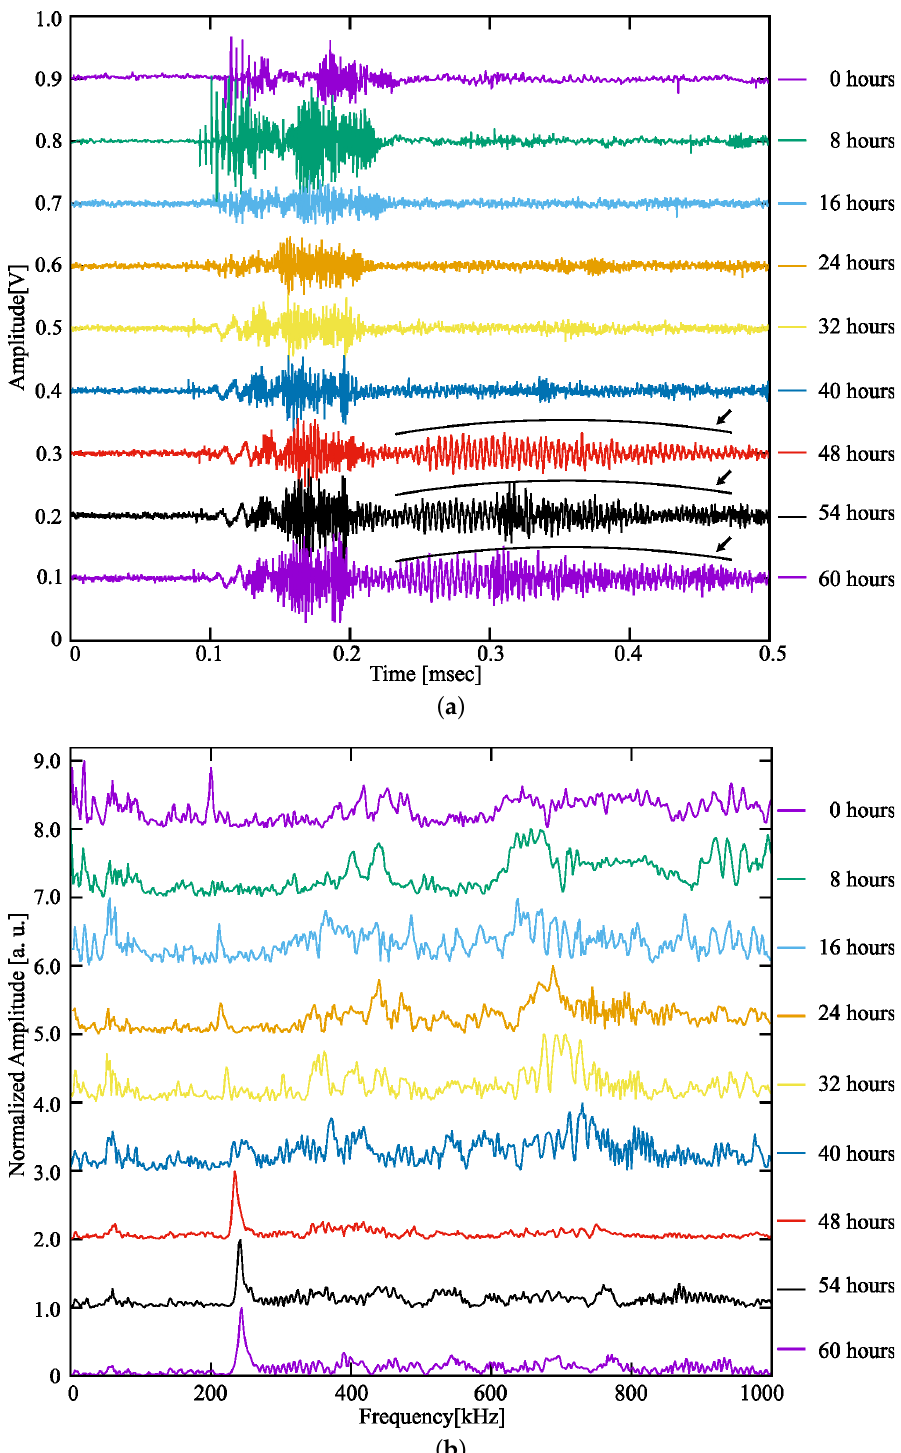
Figure 8. Summary of ( a ) ultrasonic waveforms and ( b ) frequency spectrums for the accelerated electrolytic corroded